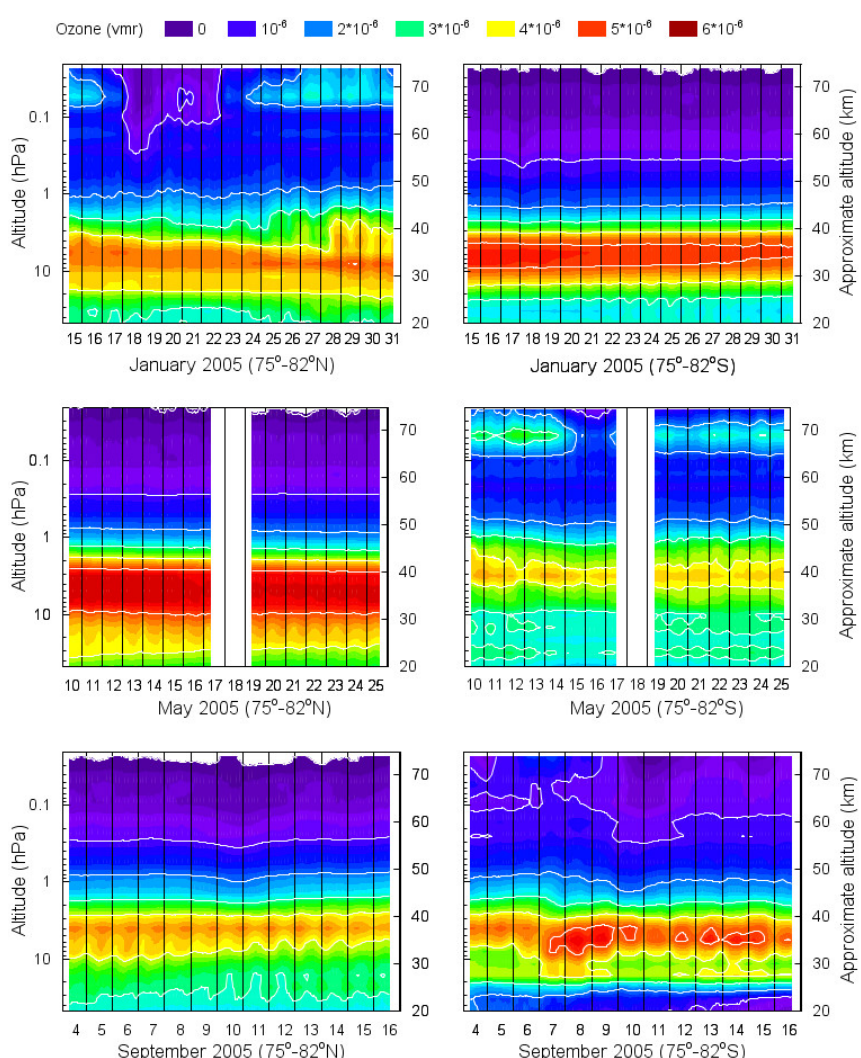
Fig. 2. Temporal evolution of averaged values ( ∼ 75 ◦ –82 ◦ N and S) of atmospheric O 3 volume mixing ratio (vmr) for the investigated 2005 SEP events: (top) January, at North 93 ◦ < SZA < 118 ◦ and at South 61 ◦ < SZA < 87 ◦ ; (middle) May, at North 56 ◦ < SZA < 80 ◦ and at South 99 ◦ < SZA < 123 ◦ ; (bottom) September, at North 68 ◦ < SZA < 94 ◦ and at South 85 ◦ < SZA < 111 ◦ . The left column reports the Northern Hemisphere and the right the Southern